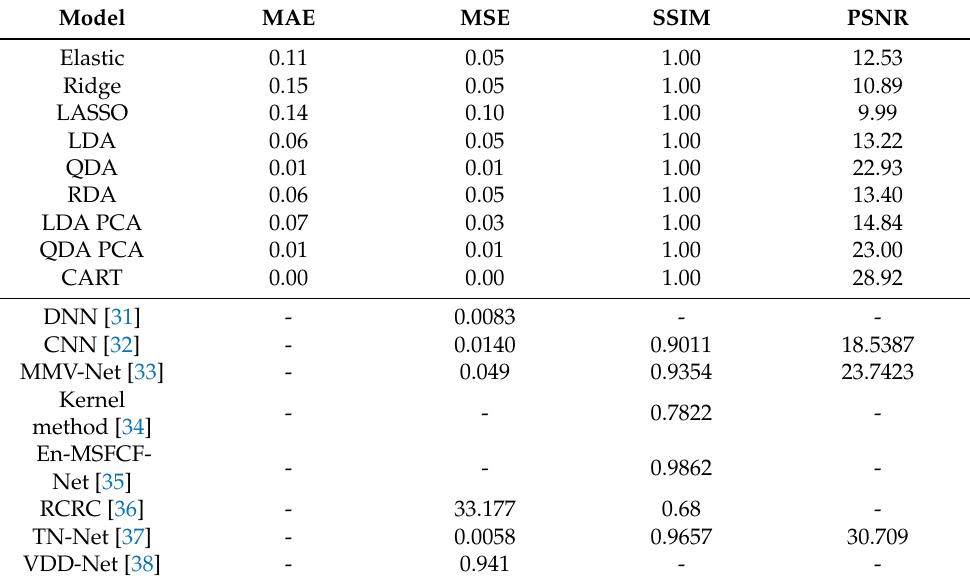
Table 5. Table of measures that determine the quality of the